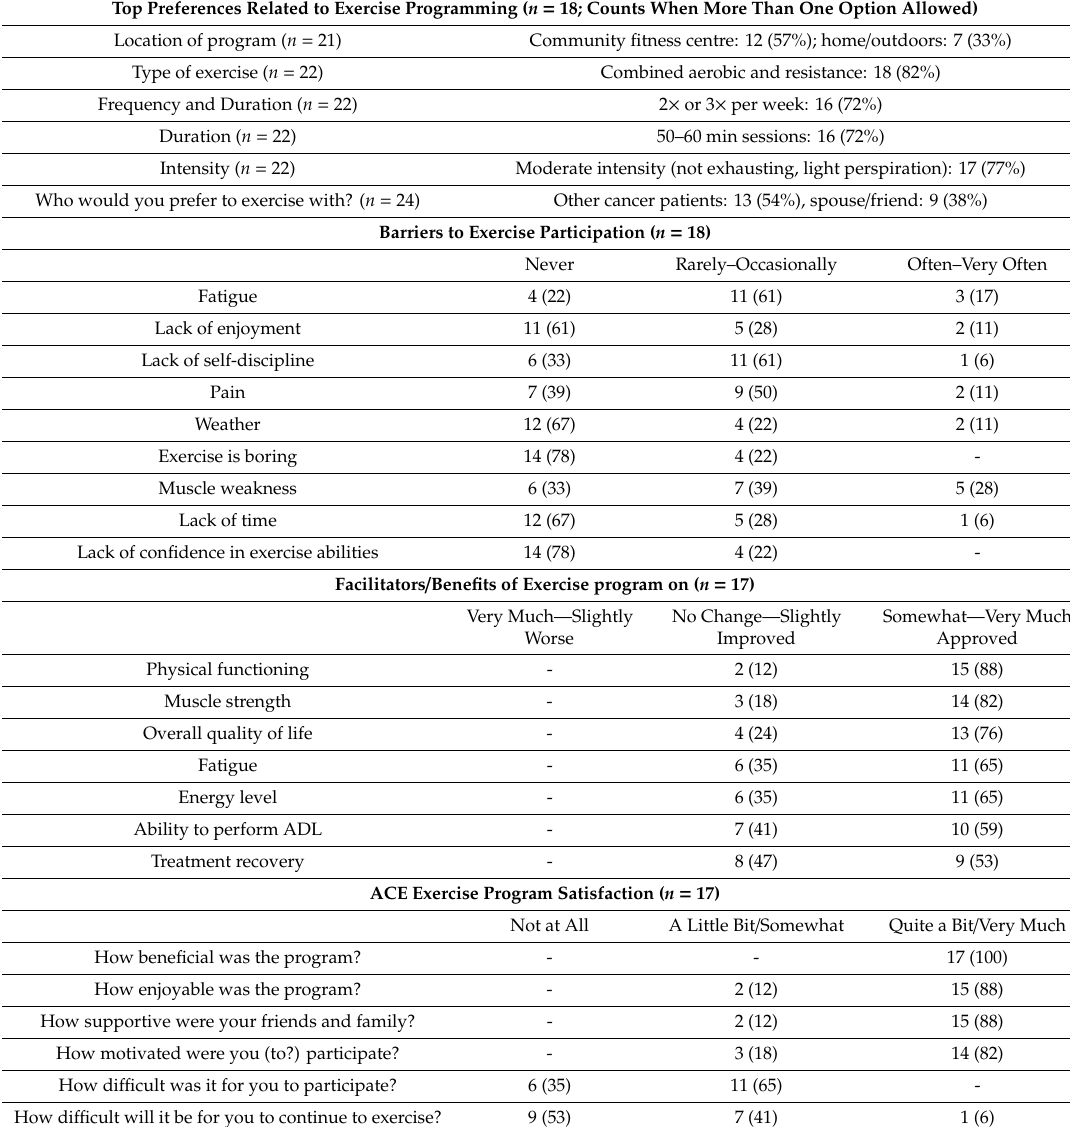
Table 3. Post-ACE preferences, barriers, facilitators / benefits and satisfaction questionnaire. Top Preferences Related to Exercise Programming ( n = 18; Counts When More Than One Option Allowed) Location of program ( n = 21) Community fitness centre: 12 (57%); home / outdoors: 7 (33%) Type of exercise ( n = 22) Combined aerobic and resistance: 18 (82%) Frequency and Duration ( n = 22) 2 × or 3 × per week: 16 (72%) Duration ( n = 22) 50–60 min sessions: 16 (72%) Intensity ( n = 22) Moderate intensity (not exhausting, light perspiration): 17 (77%) Who would you prefer to exercise with? ( n = 24) Other cancer patients: 13 (54%), spouse / friend: 9 (38%) Barriers to Exercise Participation ( n =